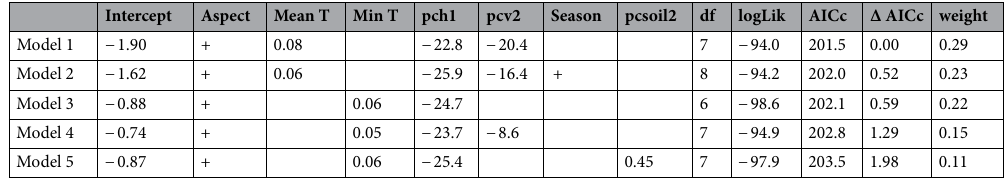
Table 3. Best general linear mixed models used in model averaging, explaining variation in functional differentiation of ant species across an altitude gradient, over the 6 years of this study within 2 AICc of the best model. Weight is a measure of the relative probability that that particular model is the best of the candidate models reported.